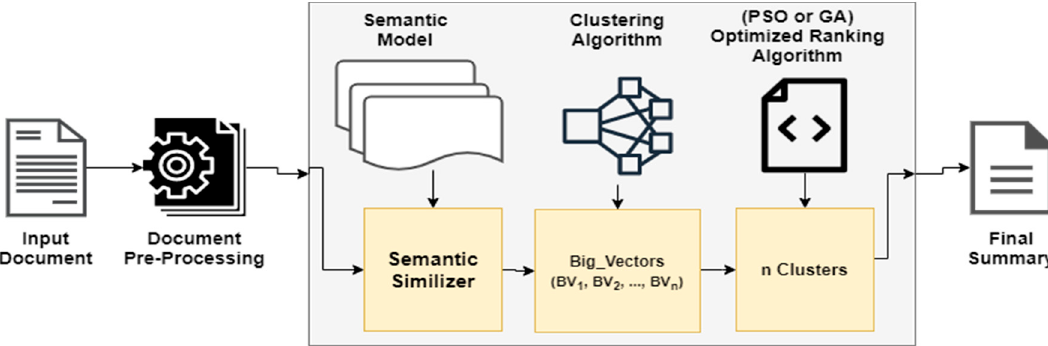
Figure 1. Proposed model overview.